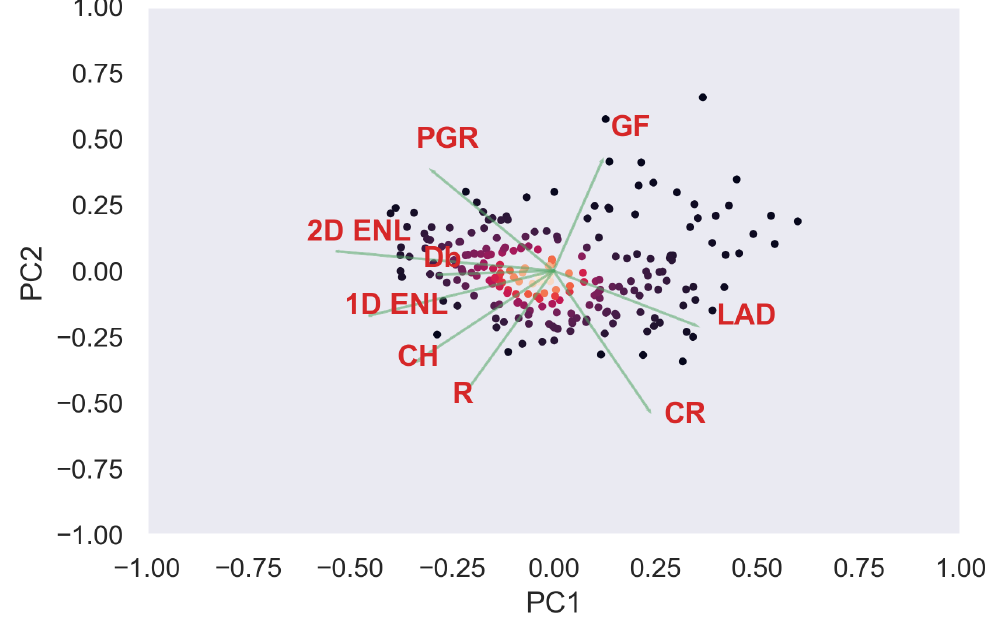
Figure A53. TLS PCA band 1 and 2 loadings at 5m grid